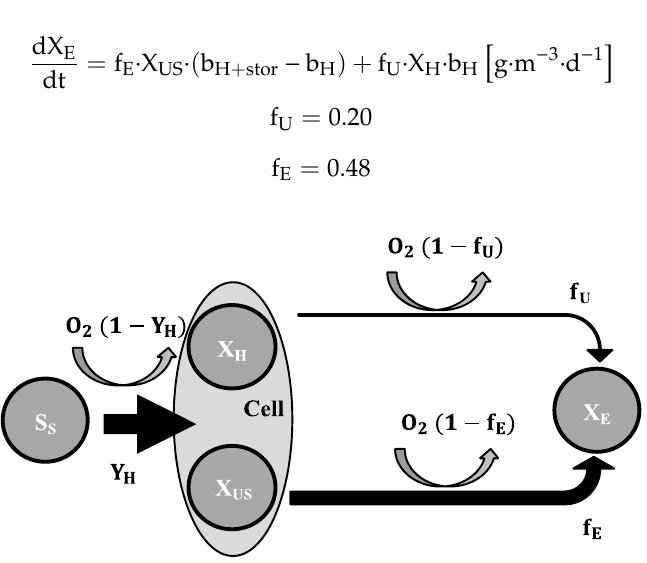
Figure 12. Adjusting of the endogenous respiration